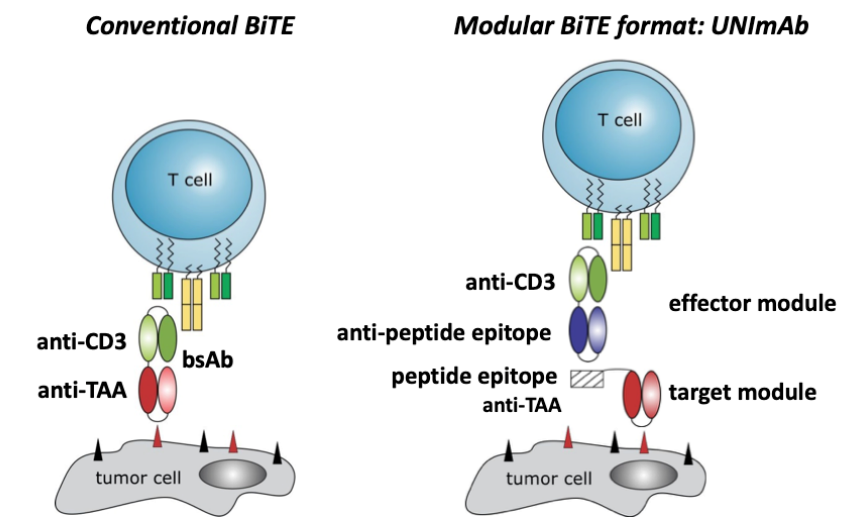
Figure 1. Schematic comparison of the conventional ( left ) and modular BiTE format: UNImAb ( right ).